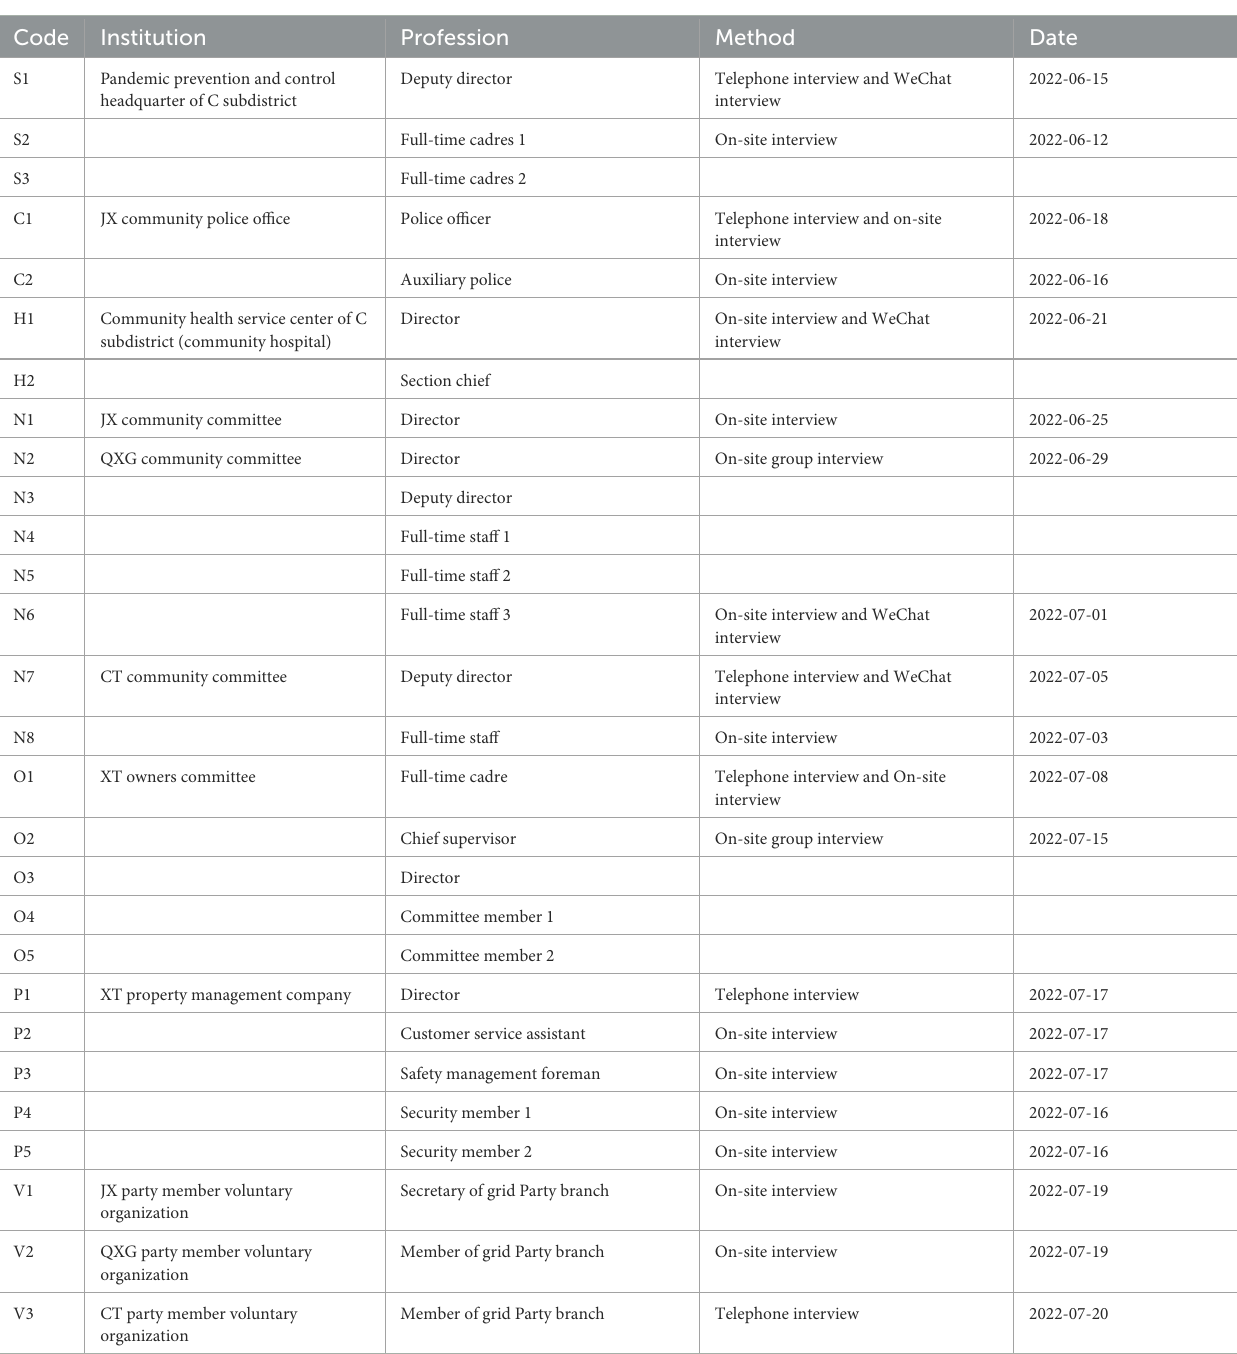
TABLE 1 Basic information of